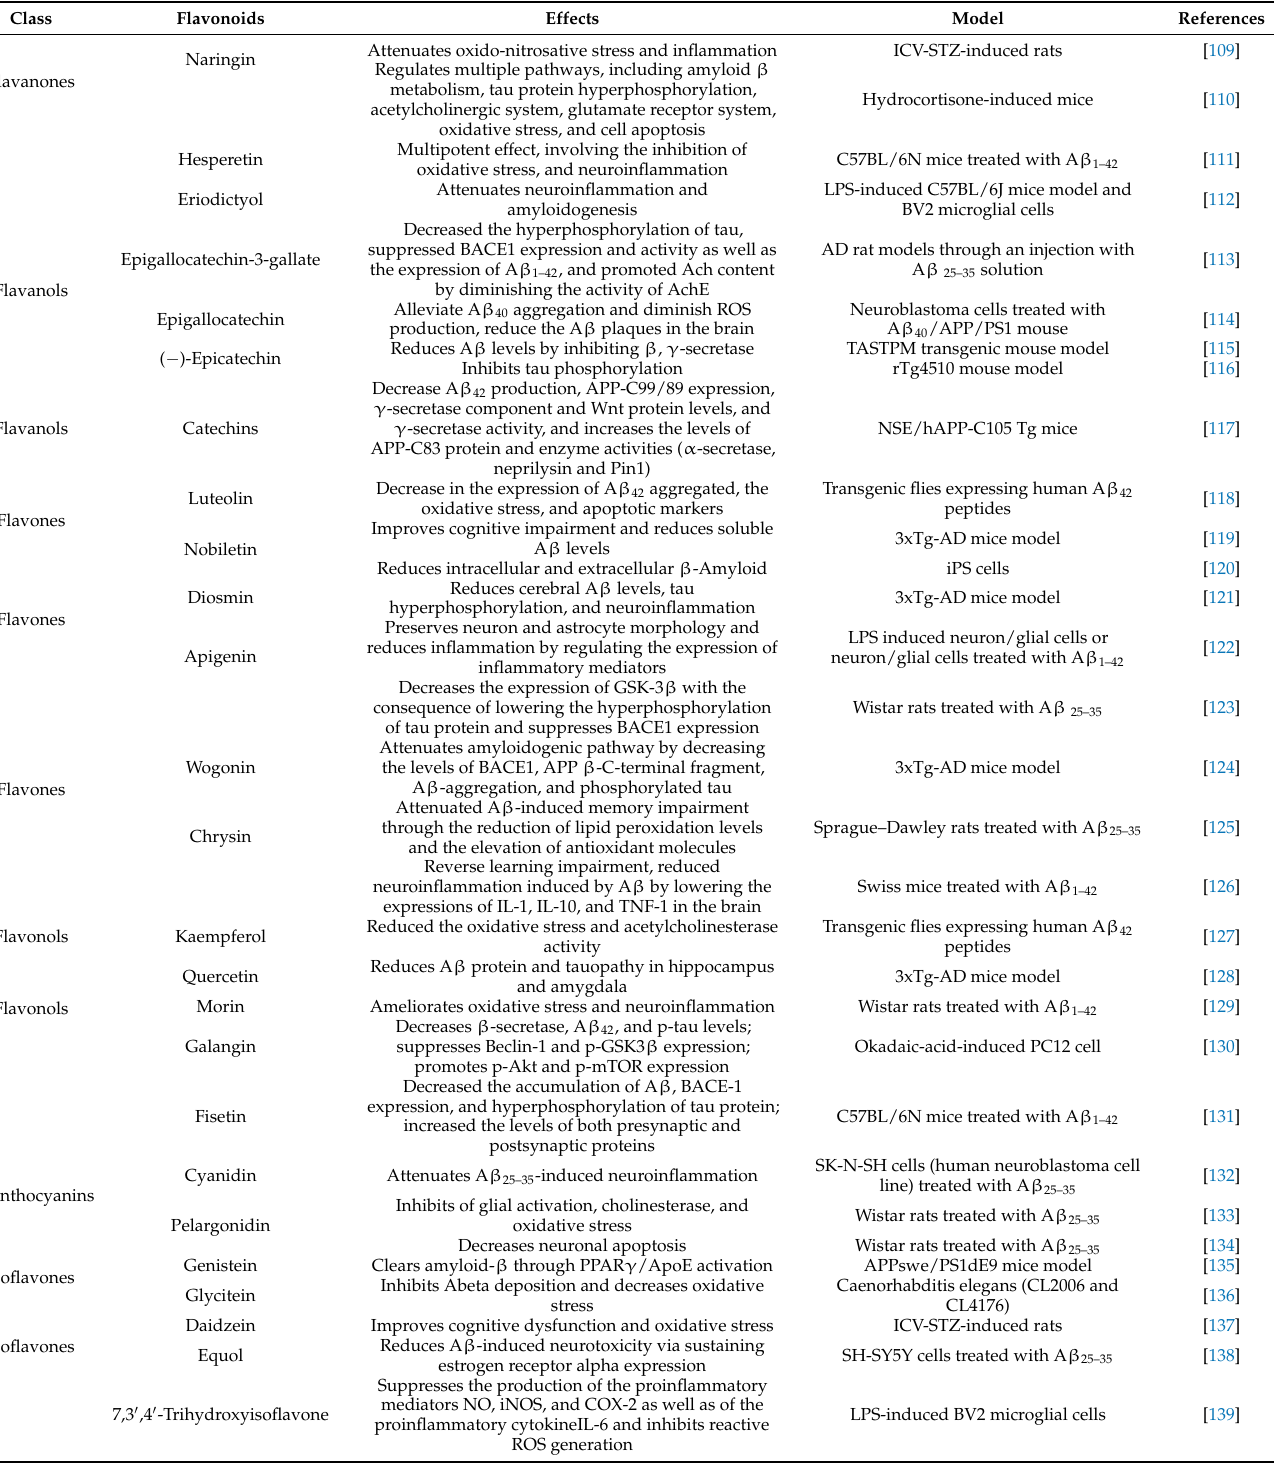
Table 4. Classification and promising preclinical studies of flavonoids and their neuroprotective role against Alzheimer’s